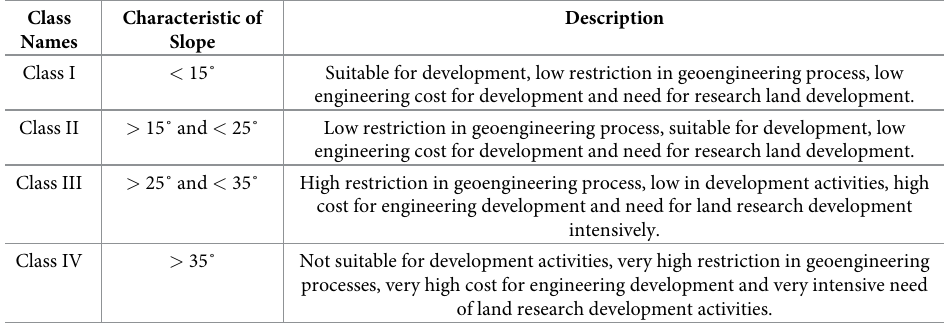
Table 6. Classification of slope ranges [9, 31,